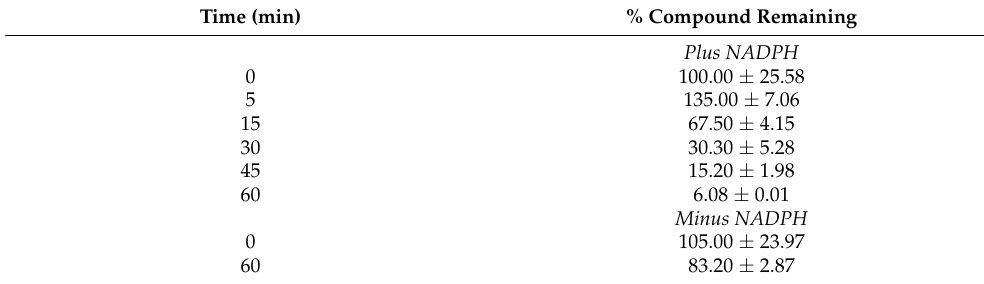
Table 5. Percentage of B06 remaining at each incubation time in